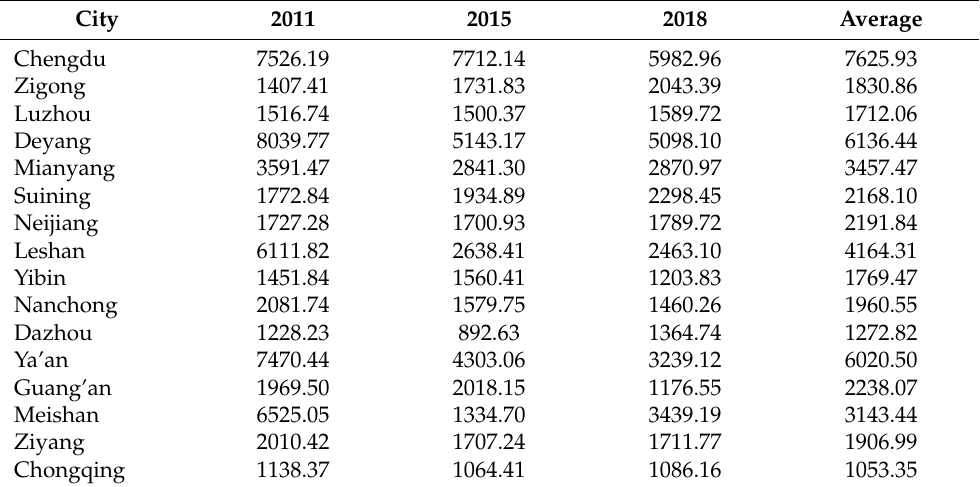
Table 2. The matching coefficient of water and land resources in Chengdu–Chongqing